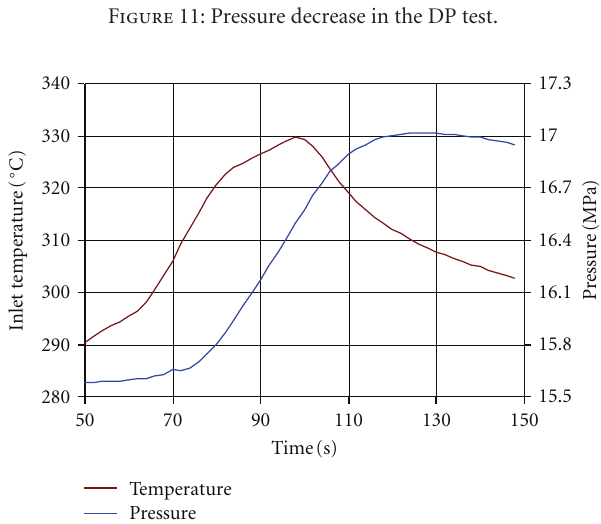
Figure 12: Inlet temperature and pressure during the TI test.